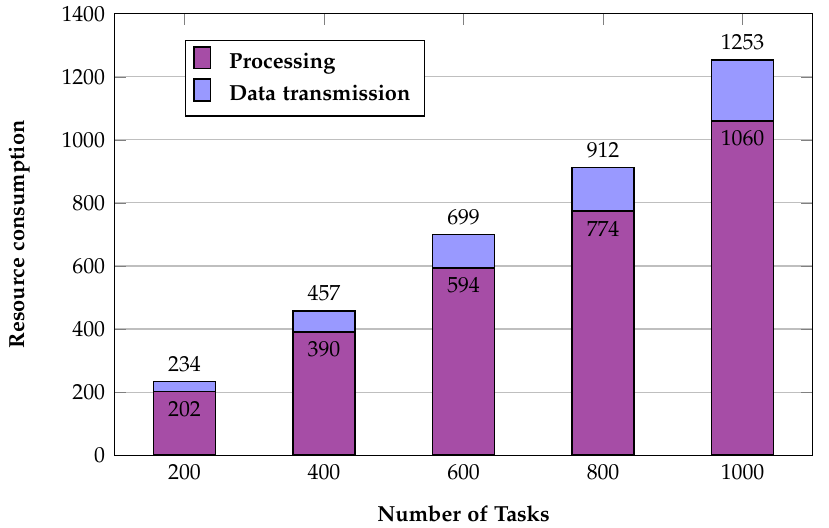
Figure 8. The consumption costs of executing